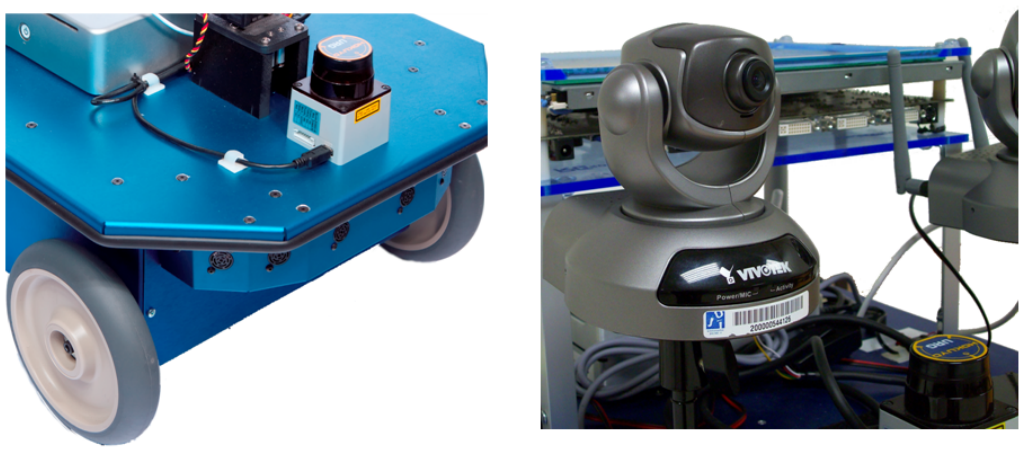
Figure 5. Erratic Videre Mobile platform equipped with Sonar ring of eight MaxSonar EZ1 and Hokuyo URG-04LX laser range-finder (left) and a Vivotek pan-tilt camera